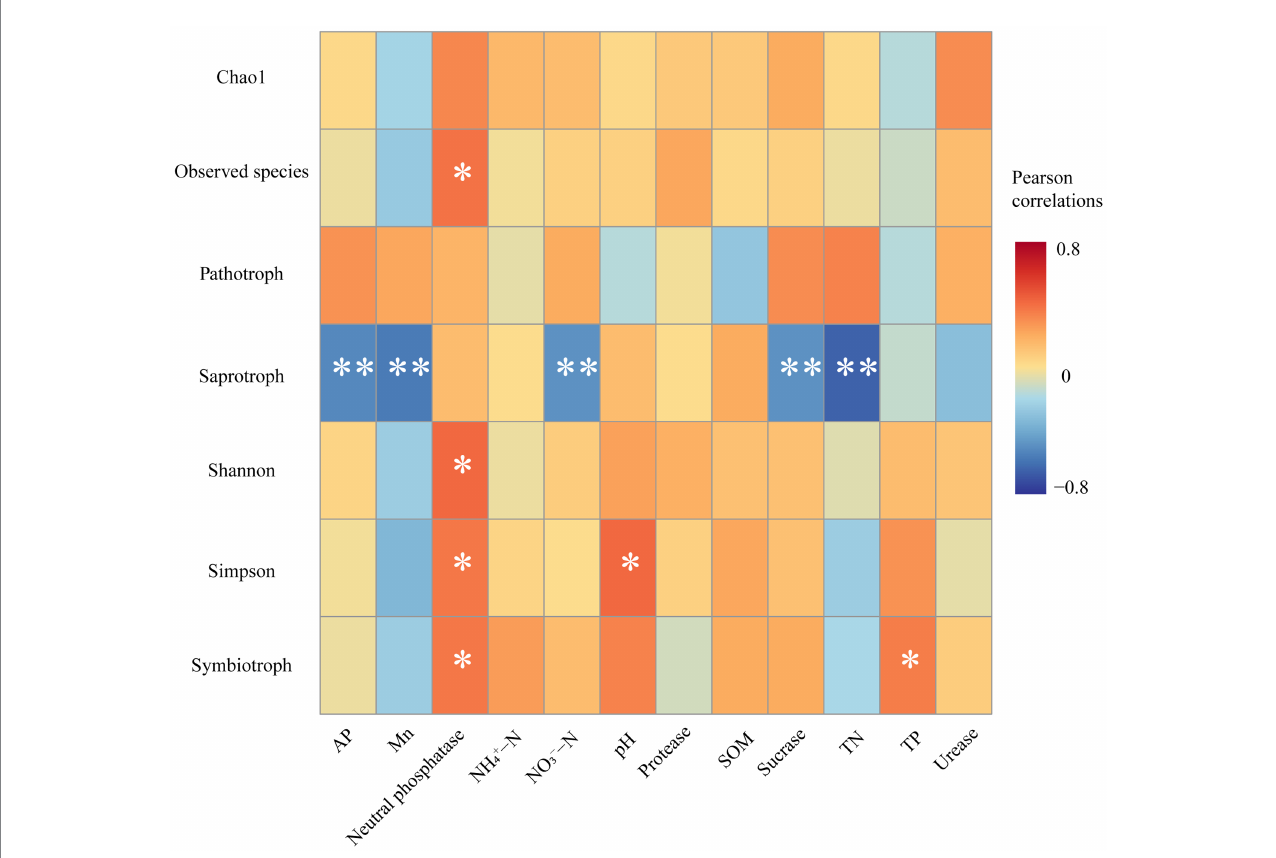
FIGURE 5 Pearson correlations between soil environmental factors, fungal diversity, and fungal functional guilds. Significances are marked as *** p ≤ 0.001; ** p ≤ 0.01; * p ≤ 0.05.